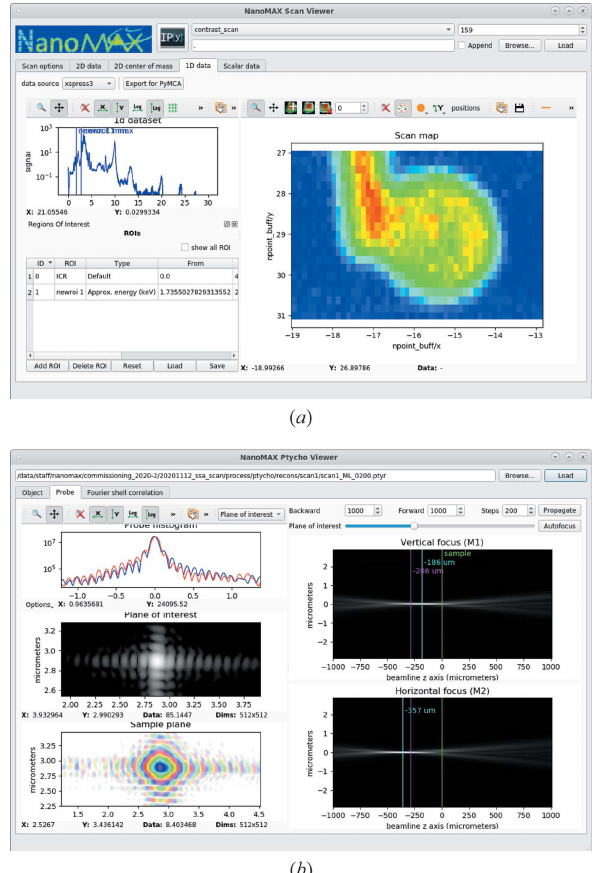
Figure 15 Screenshots of beamline applications for fast feedback on mapping and ptychography experiments. ( a ) A sample map corresponding to the integrated intensity in a region of the fluorescence emission spectrum. ( b ) A view on the probe as reconstructed by ptychography, along with a numerical wavefront propagation and information about the beam in